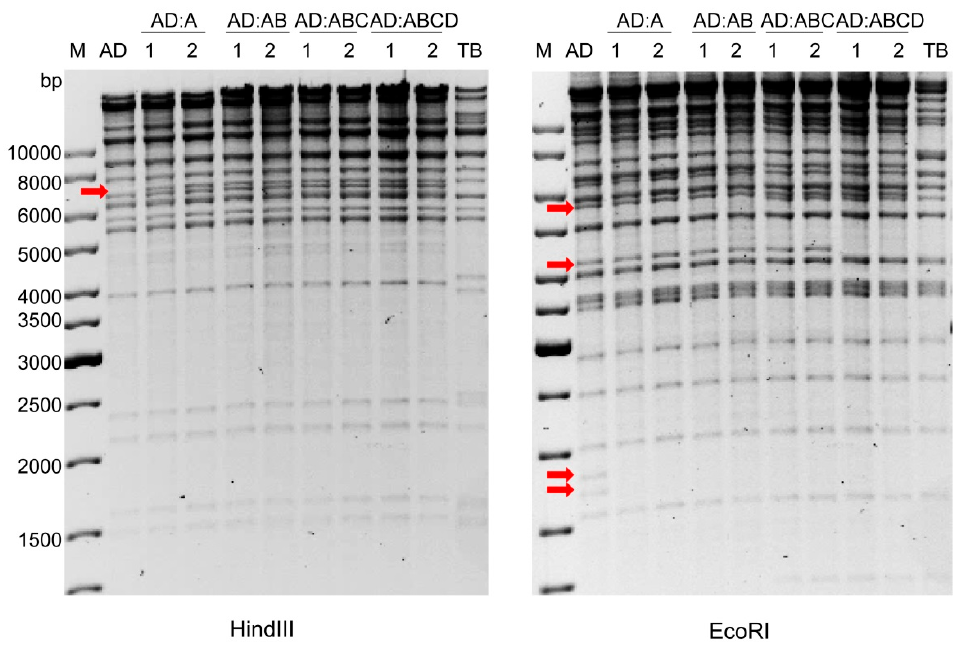
Figure 6. Restriction enzyme analysis of chimeric HCMV BACs. BAC DNAs of AD169:A, AD169:AB, AD169:ABC, and AD169:ABCD (two clones each) were isolated and analyzed by digestion with HindIII and EcoRI, respectively. Arrows indicate alterations in the restriction patterns of chimeric constructs compared to the parental AD169 (AD) genome. M, molecular weight standard; TB, TB40/E.